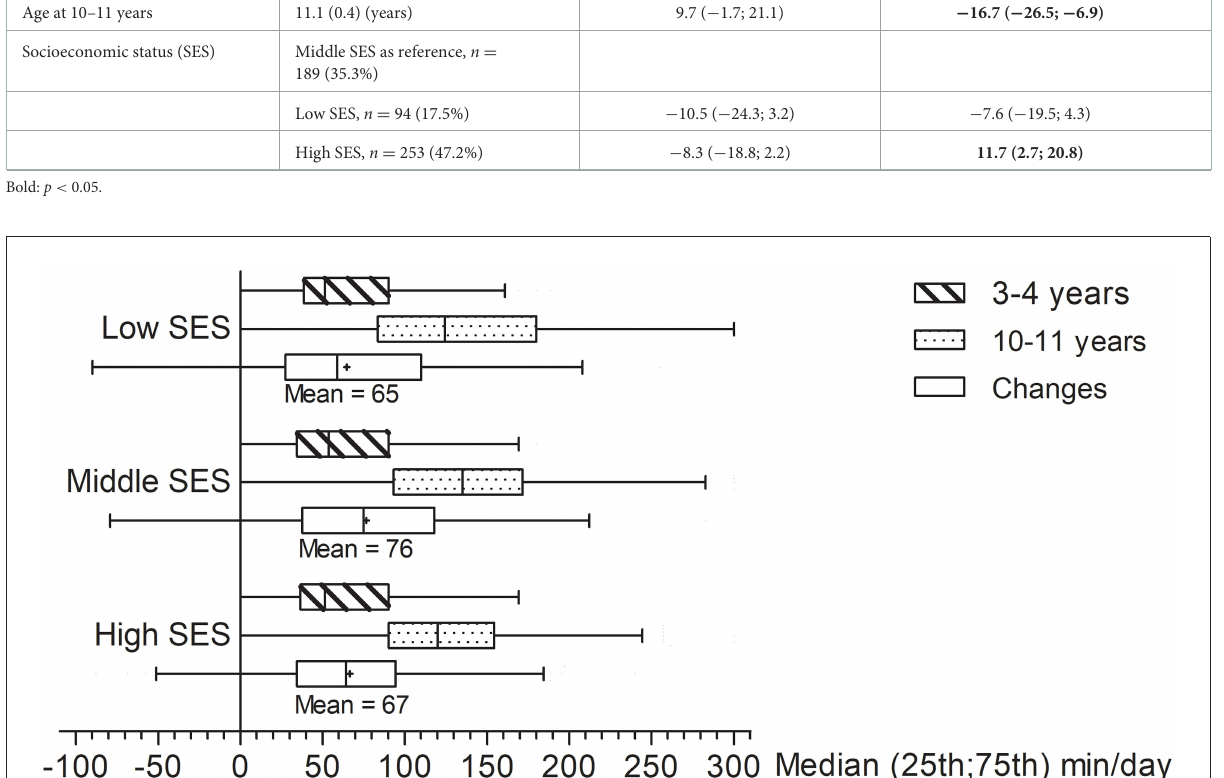
FIGURE2 Daily screen time at different ages, and changes in screen time, according to socioeconomic